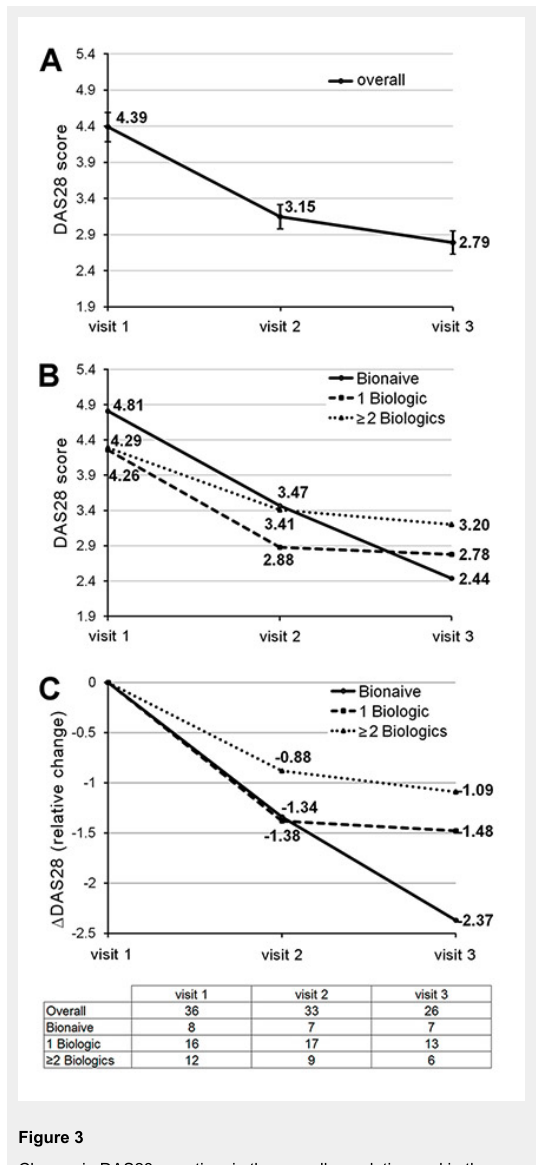
Change in DAS28 over time in the overall population and in the different subgroups. Data are mean values and, where indicated, with 95% confidence intervals. The table shows the numbers of patients with available DAS28-assessment at each visit. A) overall population; B) subgroup analysis showing absolute change in DAS28; C) subgroup analysis showing relative change in DAS28.